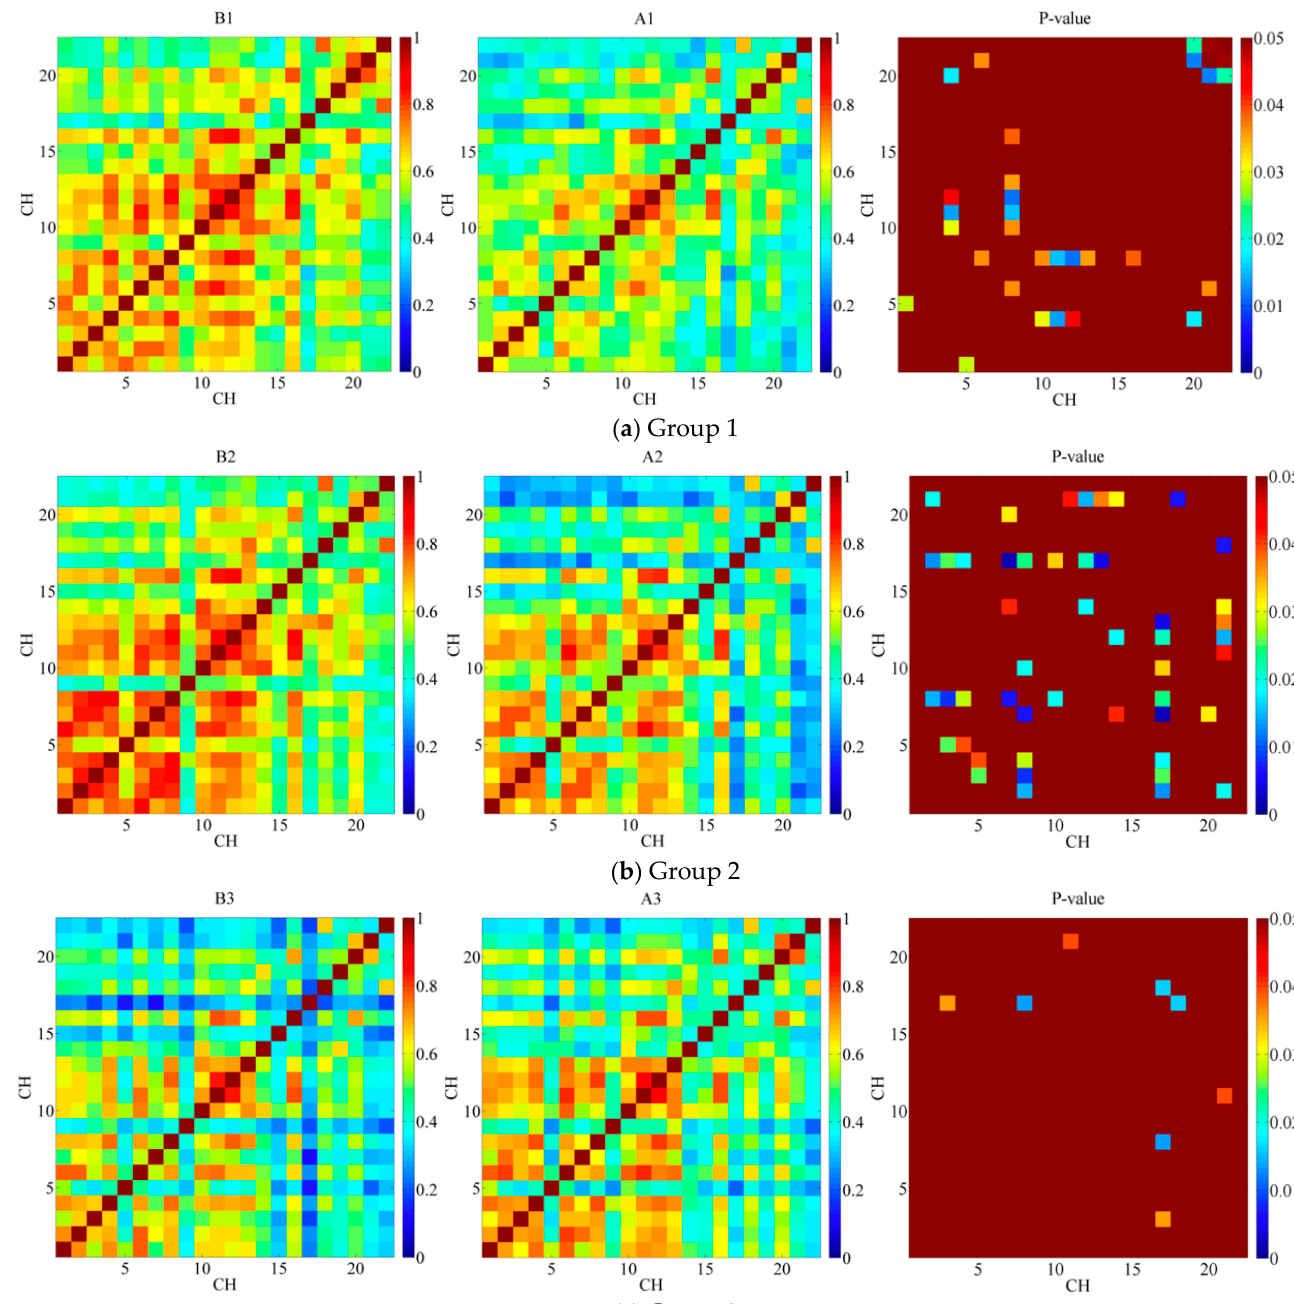
Figure 3. Functional connection matrix and p -value between each two channels of 3 shifts coal mine workers ( p < 0.05). ( a ) Group 1. ( b ) Group 2. ( c ) Group 3.